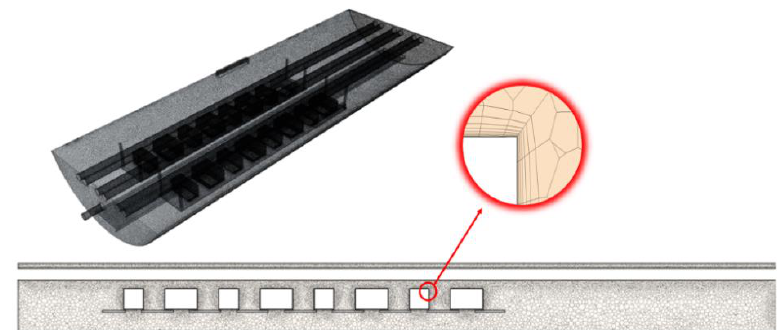
Figure 7. Mesh of the CFD model of configuration 2.